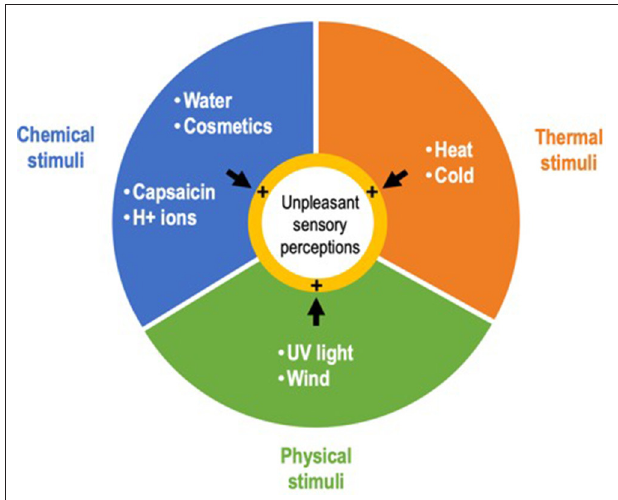
FIGURE 1 | Main exogenous stimuli triggering the unpleasant sensory perceptions that characterize sensitive skin